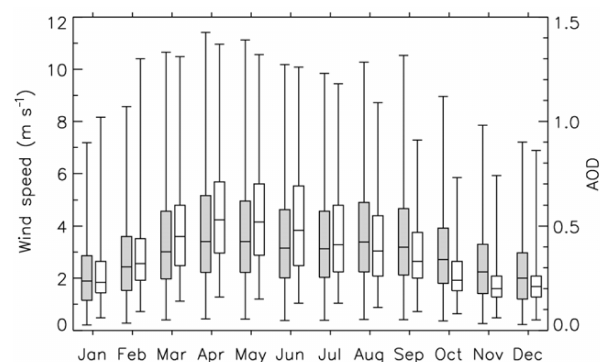
Figure 2. Annual cycles of wind speed (gray bars) and AOD (white bars) from 2000 through 2013 over the Taklimakan Desert. The hor- izontal line through each box represents that monthly median value; the top and bottom of the boxes mark 75th and 25th percentiles, re- spectively; and whiskers mark the 95th and 5th